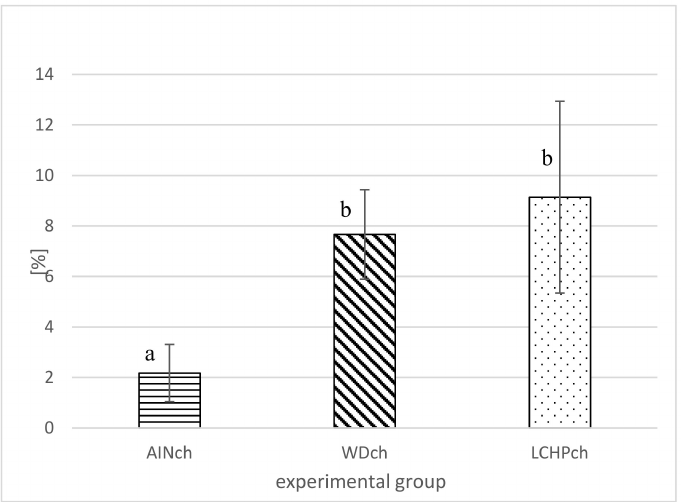
Figure 4. Liver fat (%) of rats after 8 weeks of feeding (AIN ch , WD ch or LCHP ch diets), enriched with 1% cholesterol. The means marked with letters a and b are significantly different ( p <